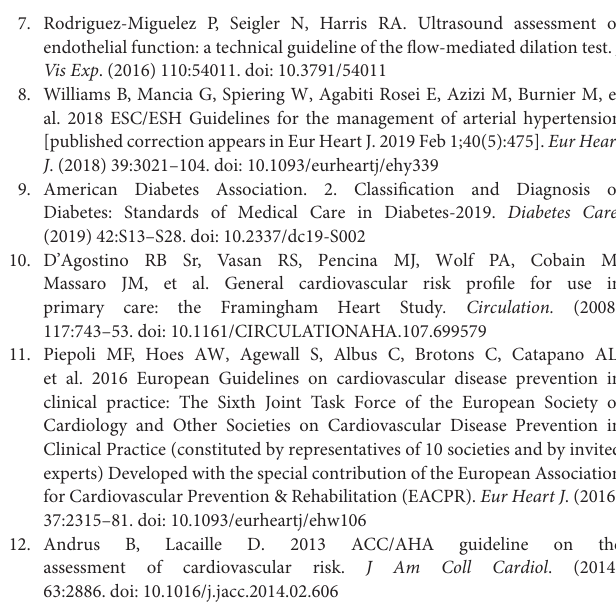
Supplementary Figure 1 | The scatter plot of the predicted FMD value and the actual FMD value. Supplementary Figure 2 | The scatter plot of age and FMD. Supplementary Figure 3 | FMD in 3 different age groups and different genders. Supplementary Figure 4 | FMD in 4 different age groups and different genders. Supplementary Figure 5 | A figure (example captured in one patient of the study sample) of a FMD